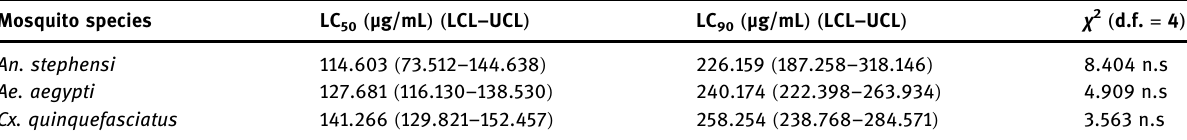
Table 1: Larval toxicity of chitosan against An. stephensi, Ae. aegypti , and Cx. quinquefasciatus